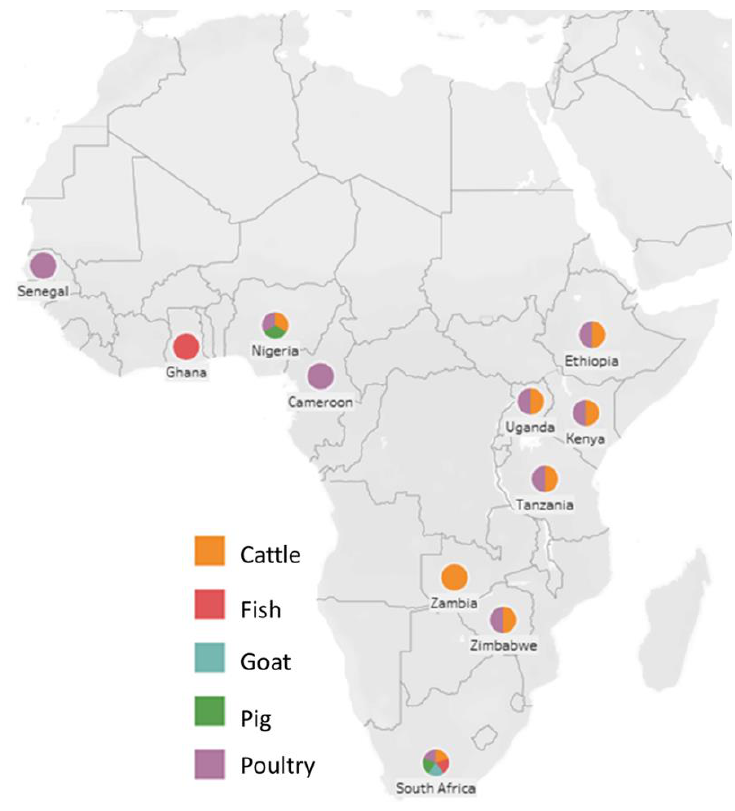
Figure 1. A map representing antibiotic resistance in different livestock species from the different countries, according to research studies carried out in the last decade.